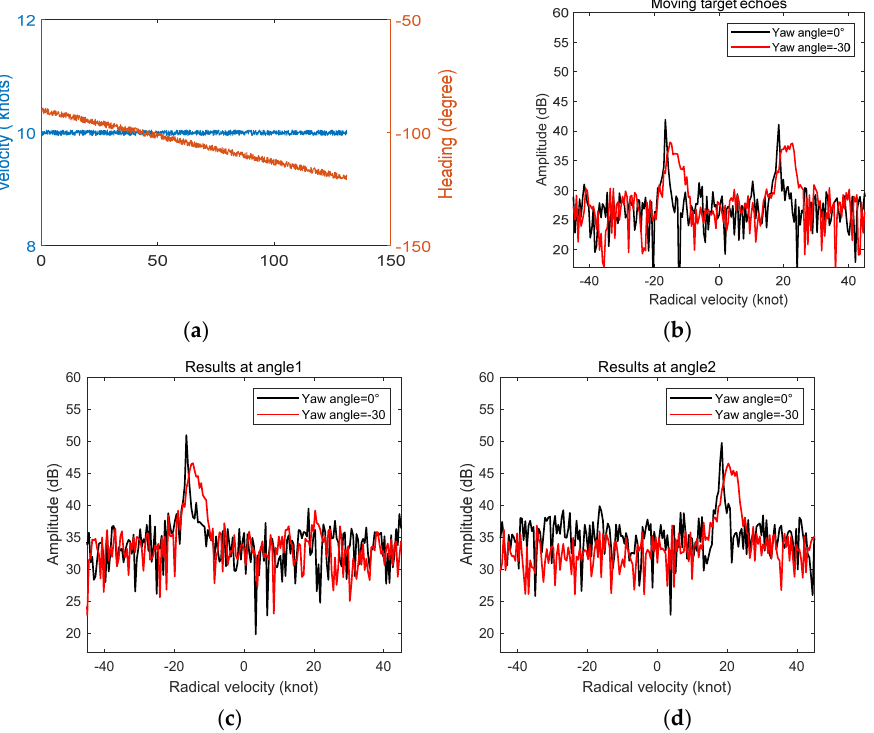
Figure 8. Simulation results of target echo in case of uniform variation of heading when velocity is 10 knots: ( a ) the distribution of the velocity and heading of the platform, ( b ) channel results, ( c ) beam results at range1, ( d ) beam results at range2.